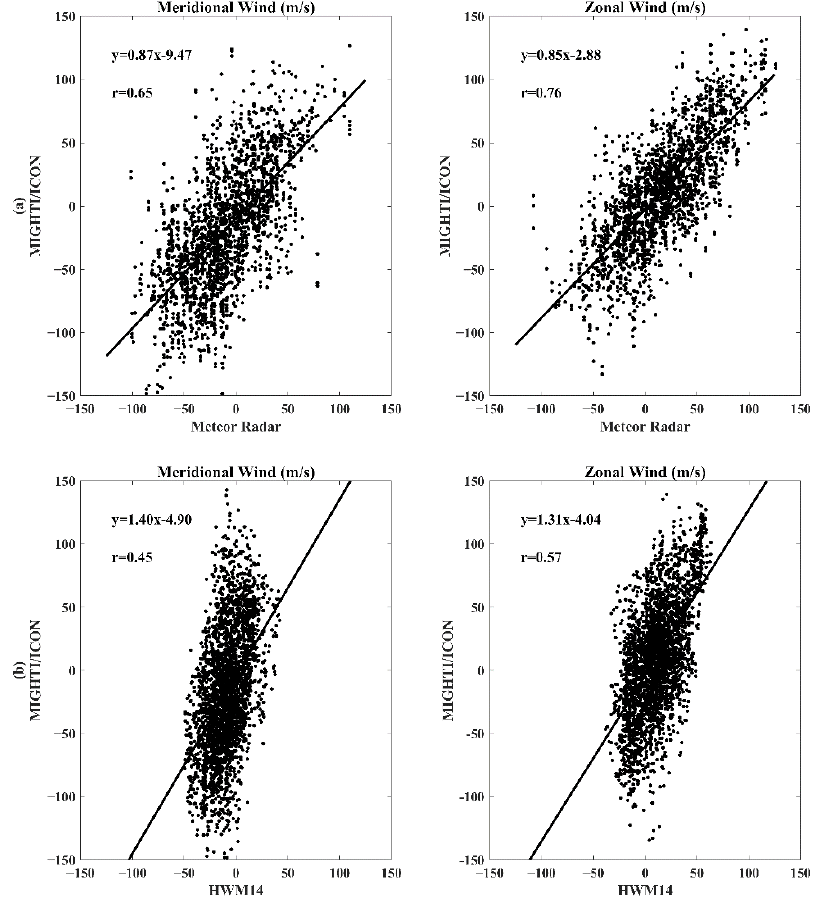
Figure 3. Scatter diagram of horizontal wind measurements from MIGHTI/ICON, meteor radar, and HWM14. The left side is for meridional winds, and the right side is for zonal winds. ( a ) MIGHTI/ICON-Meteor Radar; ( b ) MIGHTI/ICON-HWM14.